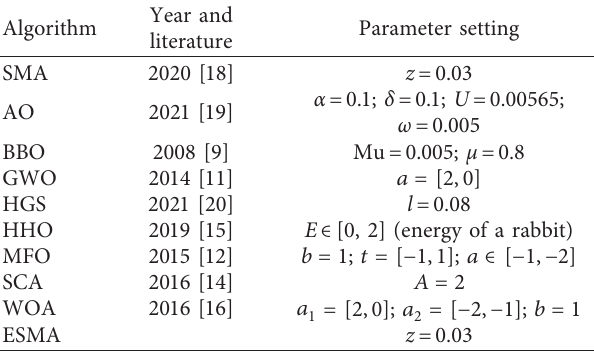
Table 3: The parameter setting of algorithms.